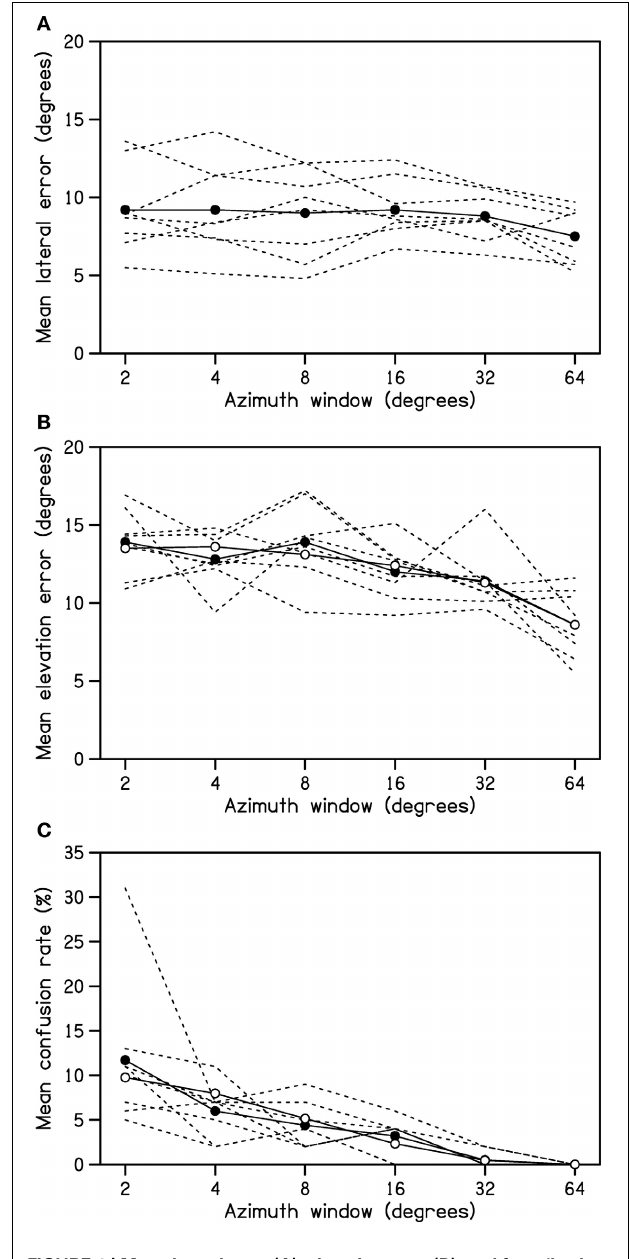
FIGURE 1 | Mean lateral error (A), elevation error (B), and front/back confusion rate (C) as functions of azimuth window width. Dashed lines represent means for individual participants. Solid symbols with solid lines represent means across participants. Open symbols with solid lines represent means predicted by the regression, partialling out the effects of duration and the extent of head rotation in elevation.